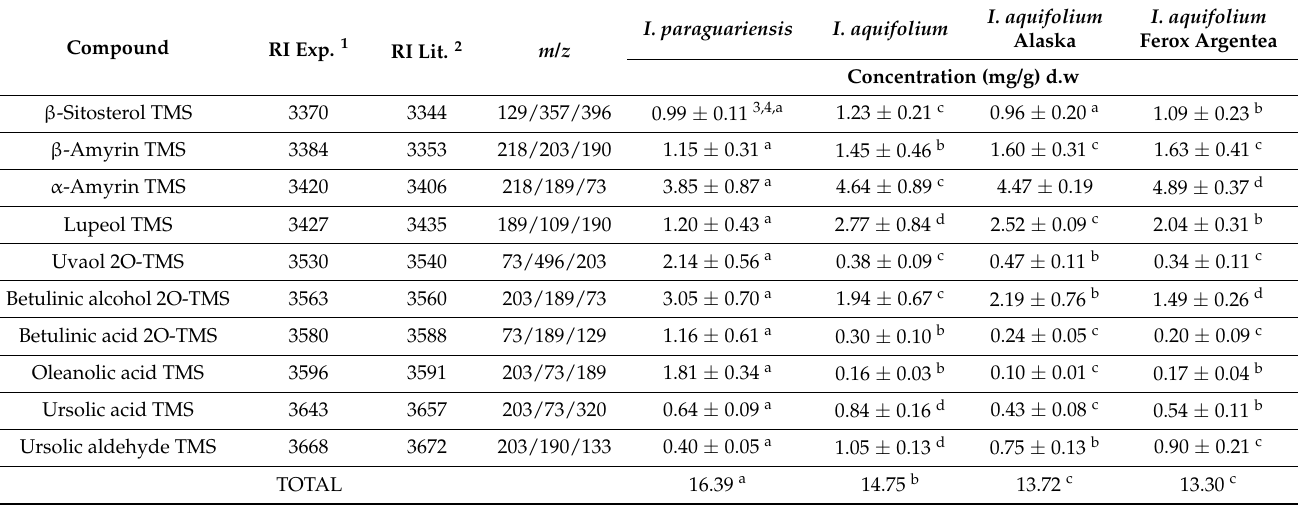
Table 3. Triterpenoid profile of I. paraquariensis and various varieties of I. aquifolium